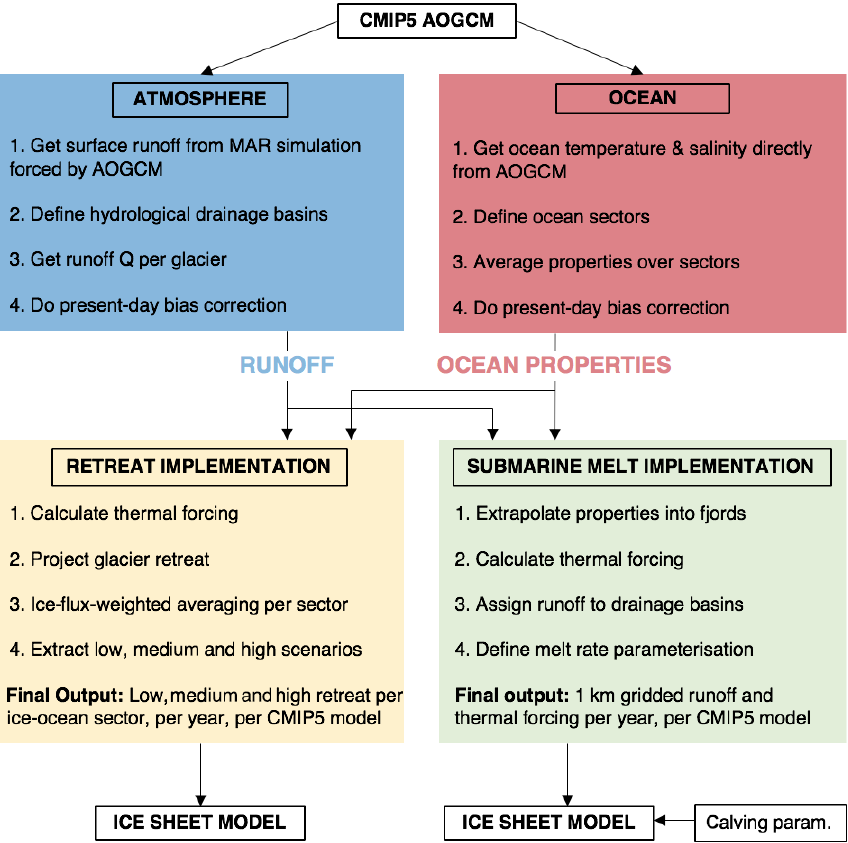
Figure 1. Schematic of proposed approach to use CMIP5 AOGCM output (top) to force Greenland ice sheet models (bottom) under the retreat and submarine melt implementations described in the text. The coloured boxes describe the methodology and analysis performed in this paper. Note that the process would be identical for CMIP6